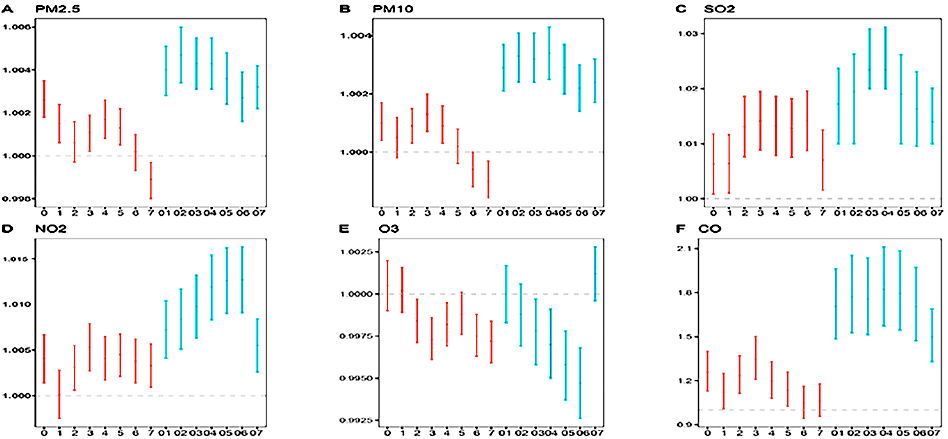
Figure 2. Percent changes and estimated relative risks (RRs) of daily influenza for a 1 µ g/m 3 (CO concentration: 1 mg/m 3 ) increase of pollutant concentrations at lag 0–lag 7 and lag 1–lag 7 during 2020–2021. Notes: the red color indicates single-day model results; the green color indicates muti- day model results.